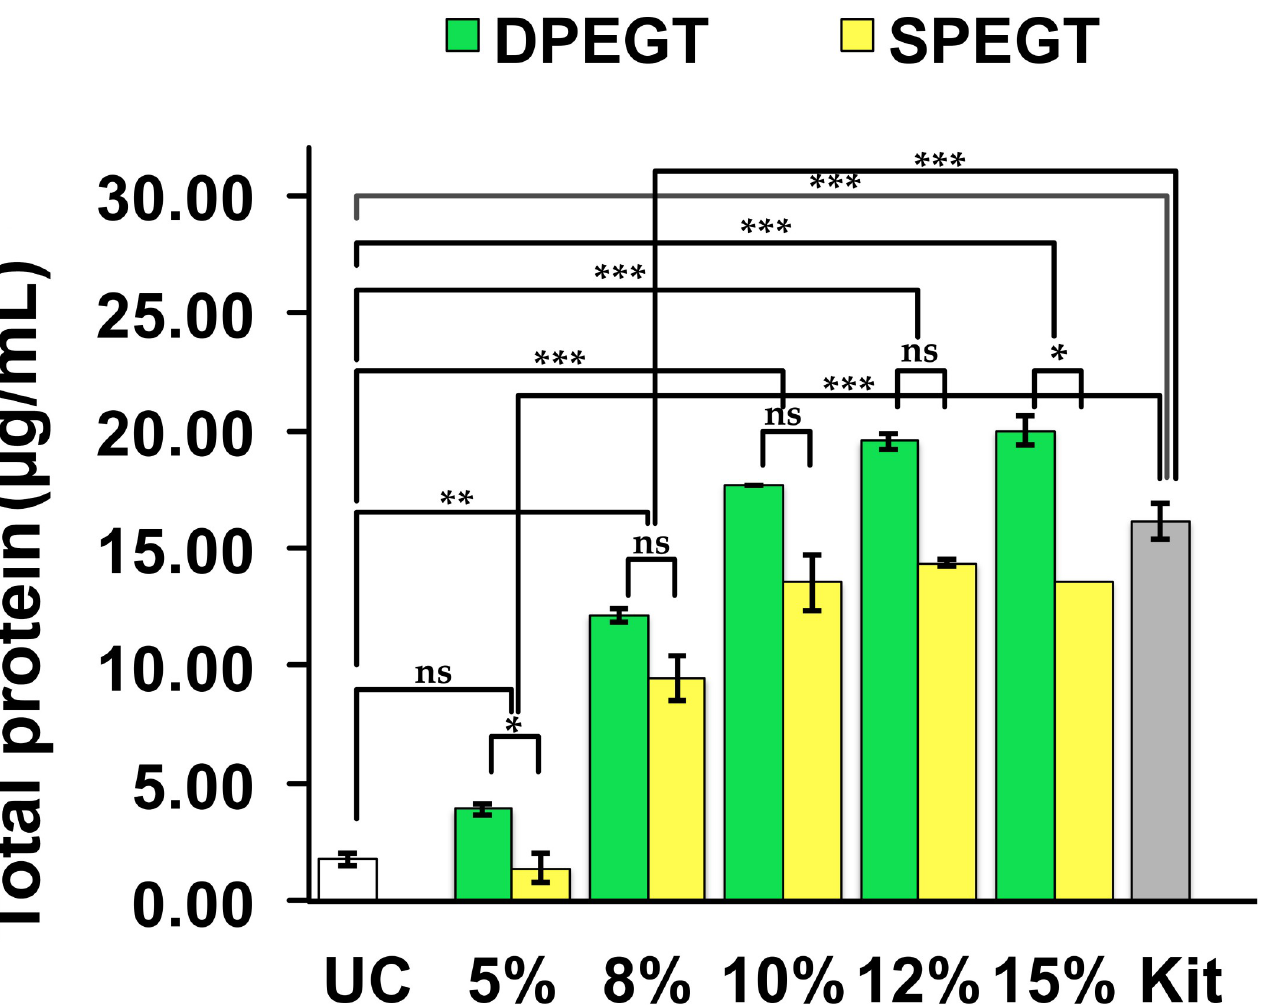
Fig 3. Total protein content of enriched plasma sEVs. Isolation of sEVs was conducted by PEG-based methods SPEGT, DPEGT, and the miRCURY kit and UC. Data represent the mean ± SEM, n = 12. ��� p < 0.001, �� p < 0.01, � p < 0.05 and ns (not significant) as determined by either Student’s t-test or ANOVA